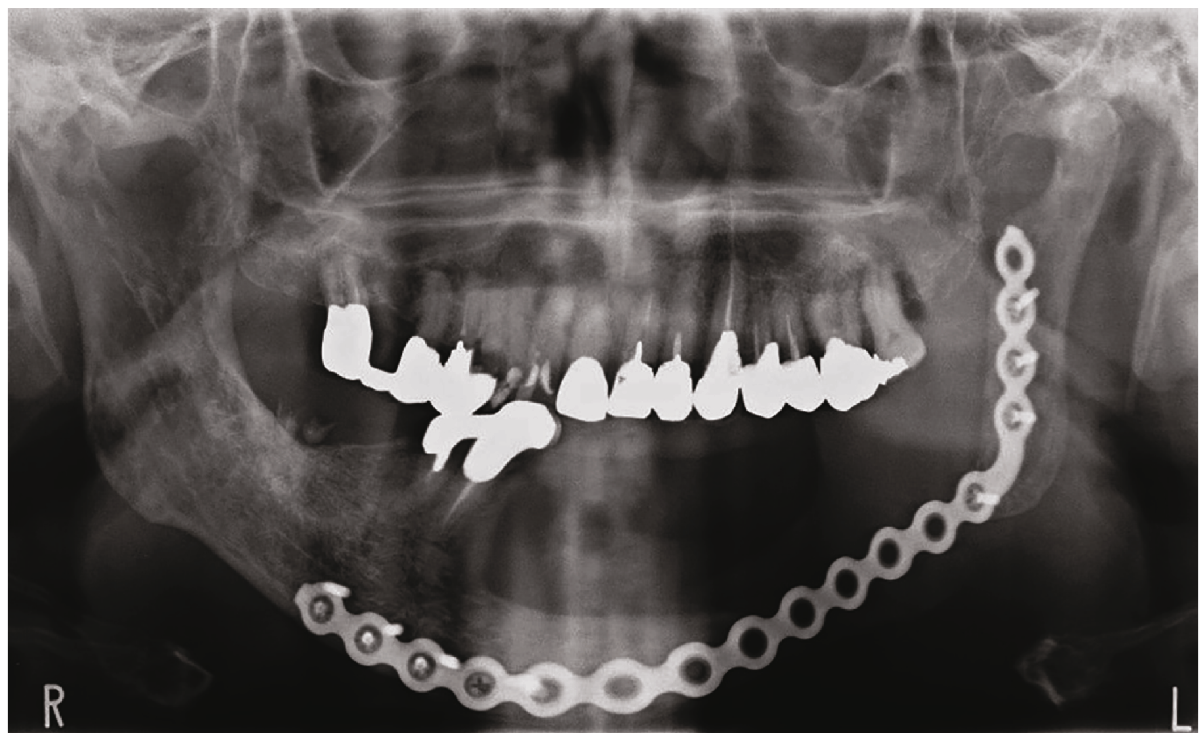
Figure 7: Postoperative panoramic X-ray showing the reconstructed mandible with a titanium